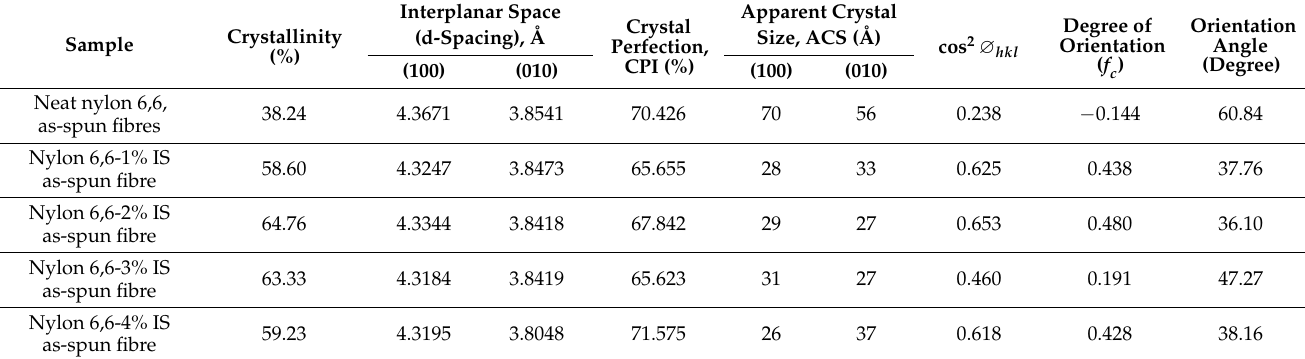
Figure 5. XRD pattern of 3% salt-confined as-spun and drawn nylon 6,6 fibres at drawing temper- ature of 140 ° C.